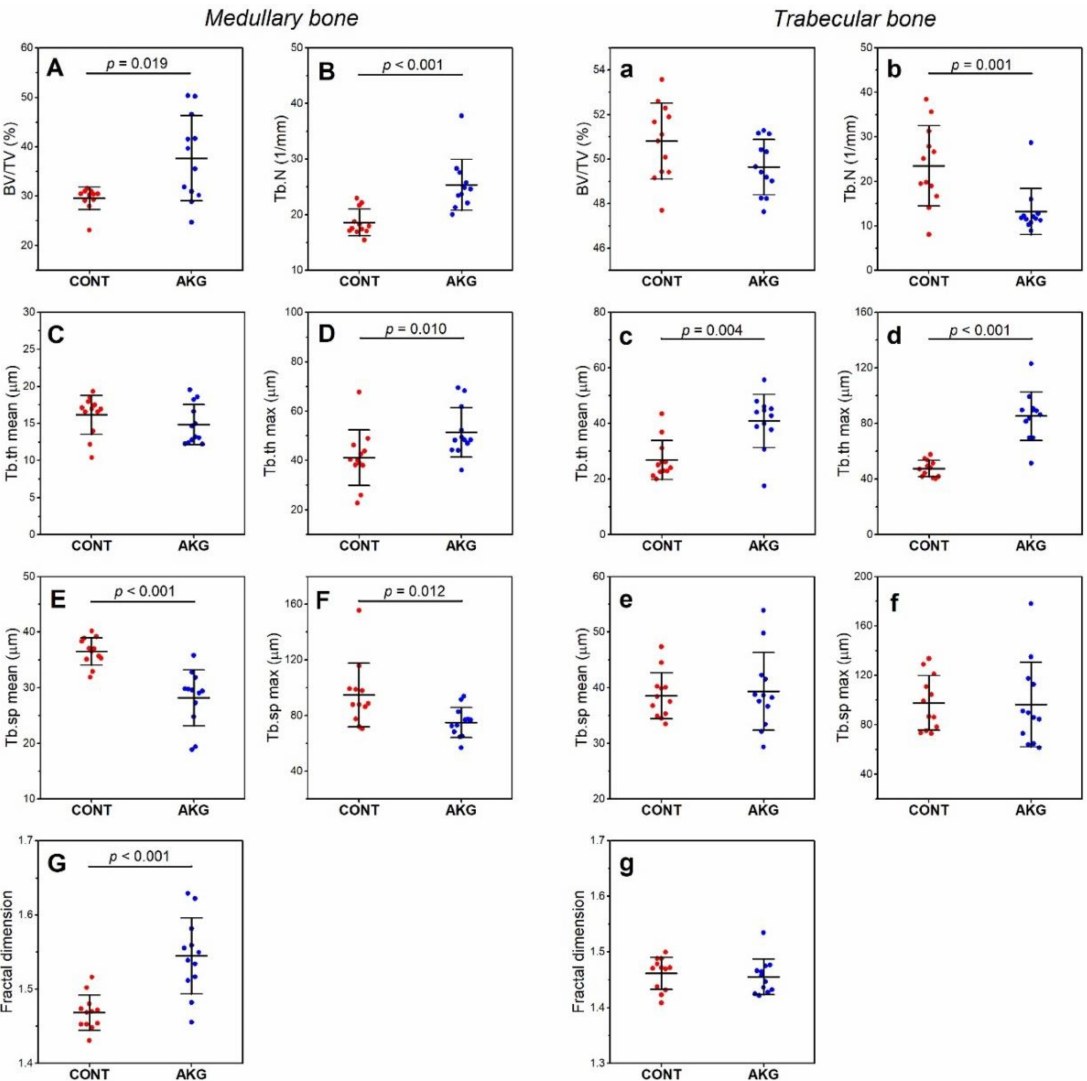
Figure 2. The e ff ect of dietary supplementation with AKG during the experimental period (31–60 weeks of age) on the histomorphometry of tibial medullary bone ( A – G ) and trabecular bone ( a – g ) in laying hens at the age of 60 weeks. BV / TV—relative bone volume; Tb.N—trabecular number; Tb.Th—trabecular thickness; Tb.Sp—trabecular separation. The CONT group included laying hens not supplemented with AKG; the AKG group included laying hens supplemented with AKG at a dose of 1.0% (10 g / kg feed). Data are mean values ± standard deviation (whiskers) from n = 12 laying